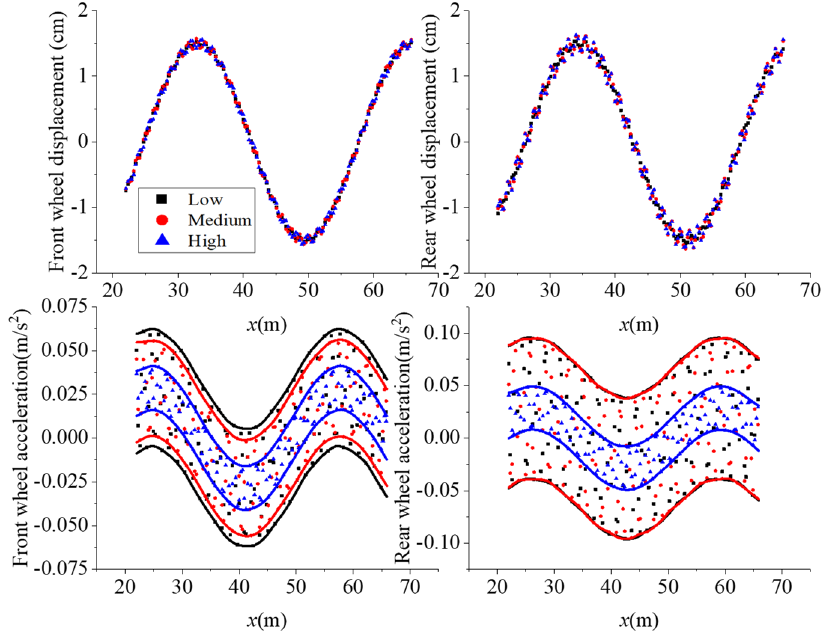
Figure 15. Net displacement and vertical acceleration ( b + c ) ≤ x ≤ 2 ns ( n ∈ N* ) (The black line is the envelope of sca tt ered points at low sti ff ness ratio; the red line is the envelope of sca tt ered points at medium sti ff ness ratio; the blue line is the envelope of sca tt ered points at high sti ff ness ratio). It is observed that the displacement is not obvious under di ff erent sti ff ness ratios.